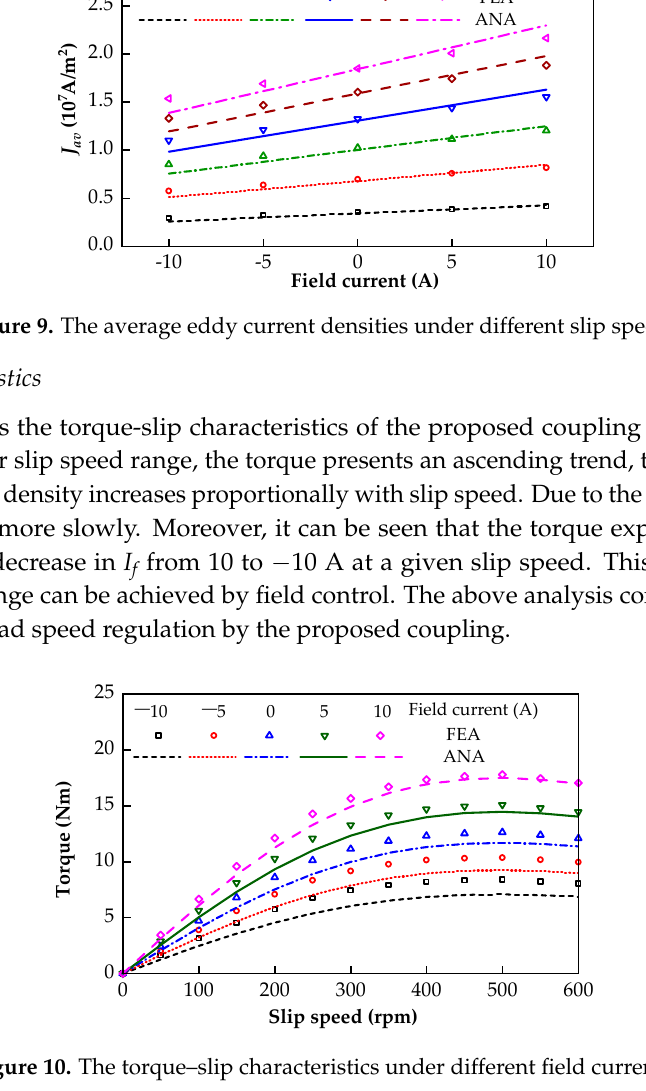
Figure 10. The torque–slip characteristics under different field currents.